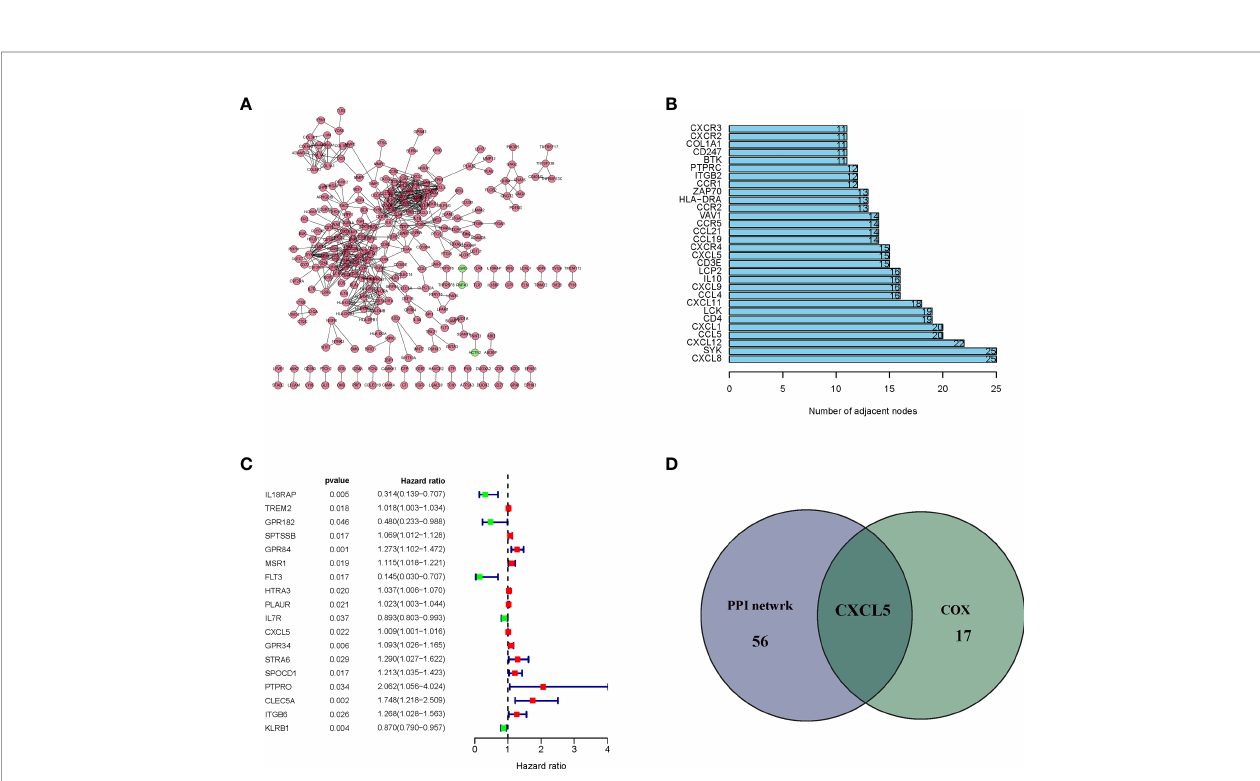
FIGURE 4 | Protein – protein interaction network and univariate cox. (A) Interaction network constructed with the nodes with interaction con fi dence value > 0.95; (B) The top 30 genes ordered by the number of nodes; (C) Univariate cox regression analysis with 830 DEGs, listing the top signi fi cant factors with P < 0.005; (D) Venn plot showing the common factors shared by leading 30 nodes in PPI and top signi fi cant factors in univariate